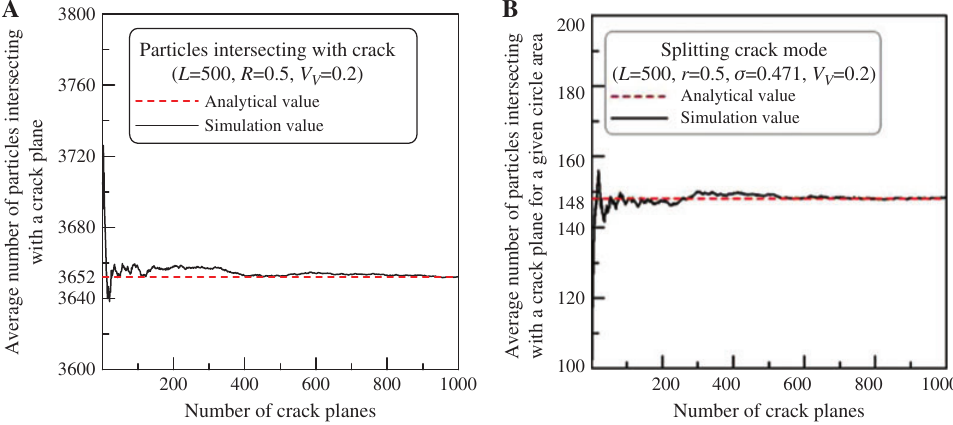
Figure 4 Simulation of the behavior of unhydrated cement particles intersecting with test crack plane and verifi cation of the reliability of theoretical models for splitting crack mode: (A) verifi cation of the reliability for Eq. (5); (B) verifi cation of the reliability for Eq.